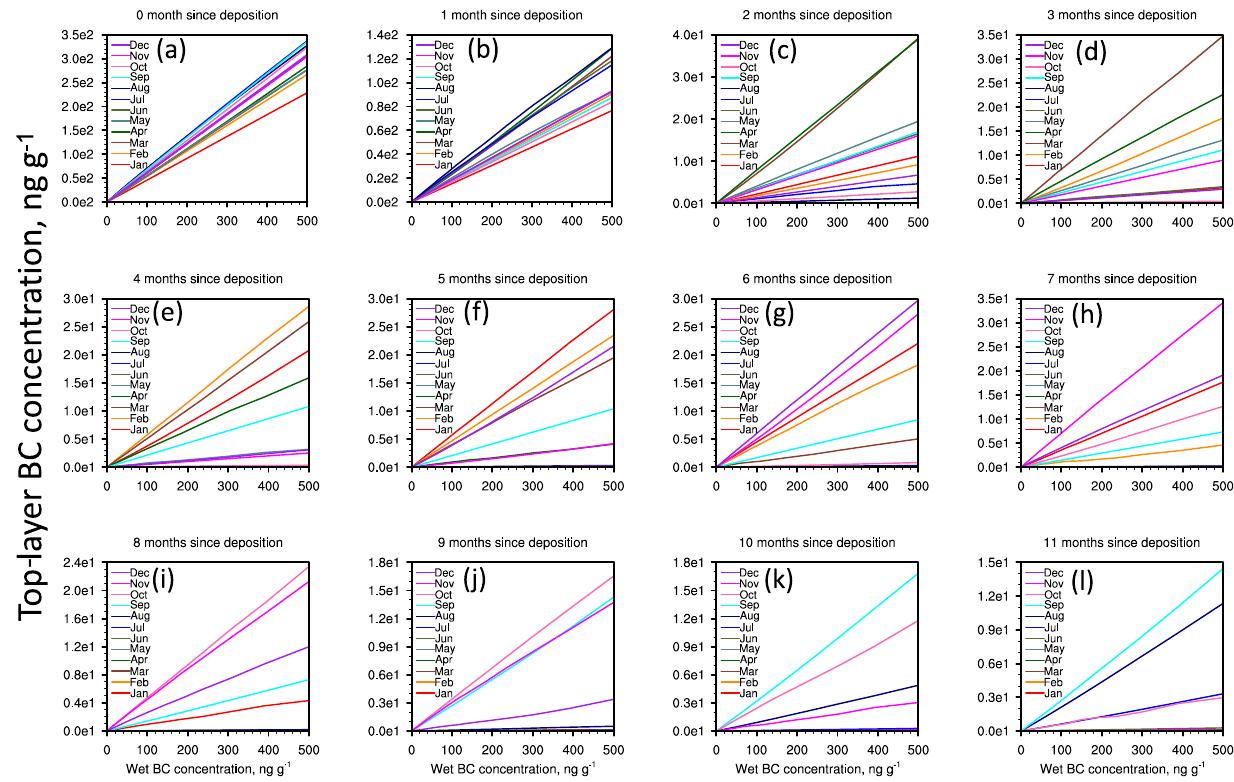
Figure 5. Hydrophilic BC concentration in the top snow layer vs. concentration of BC in precipitation shown at different times (0–11 months, panels a–l ) since deposition. The top-snow-layer concentrations are averaged over the Greenland region and over 10 1-year simulations beginning in the years 2006–2015. Different line colors represent different deposition